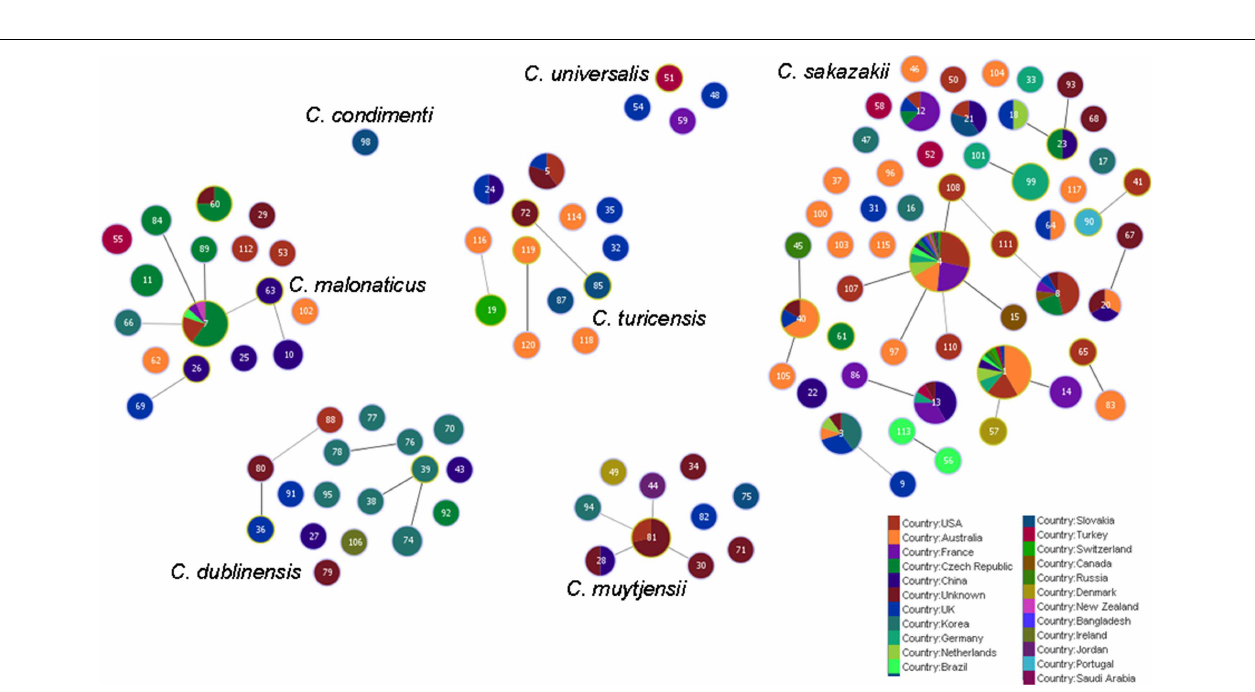
FIGURE 5 | Population snapshot of the Cronobacter MLST database generated using the goeBURST algorithm, indicating the clonal complexes and the breakdown of the species of the strains. The threshold for the output was set to triple locus variation.The dominant STs are represented by the circles with larger diameters.